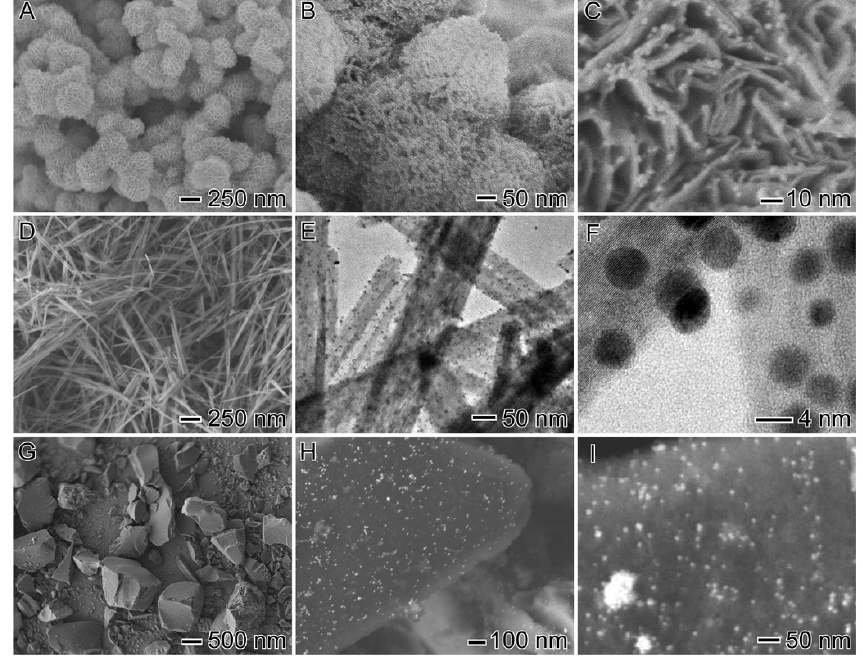
Figure 1. TEM images of the Au/MnO 2 -NF catalysts ( B , C ), Au/MnO 2 -NW ( E , F ) and Au/MnO 2 -Comm ( H , I ) catalysts. Images ( A , D , G ) represent MnO 2 -NF, MnO 2 -NW and MnO 2 -Comm bare supports, respectively. Images ( C , H , I) represent HAADF-STEM images.